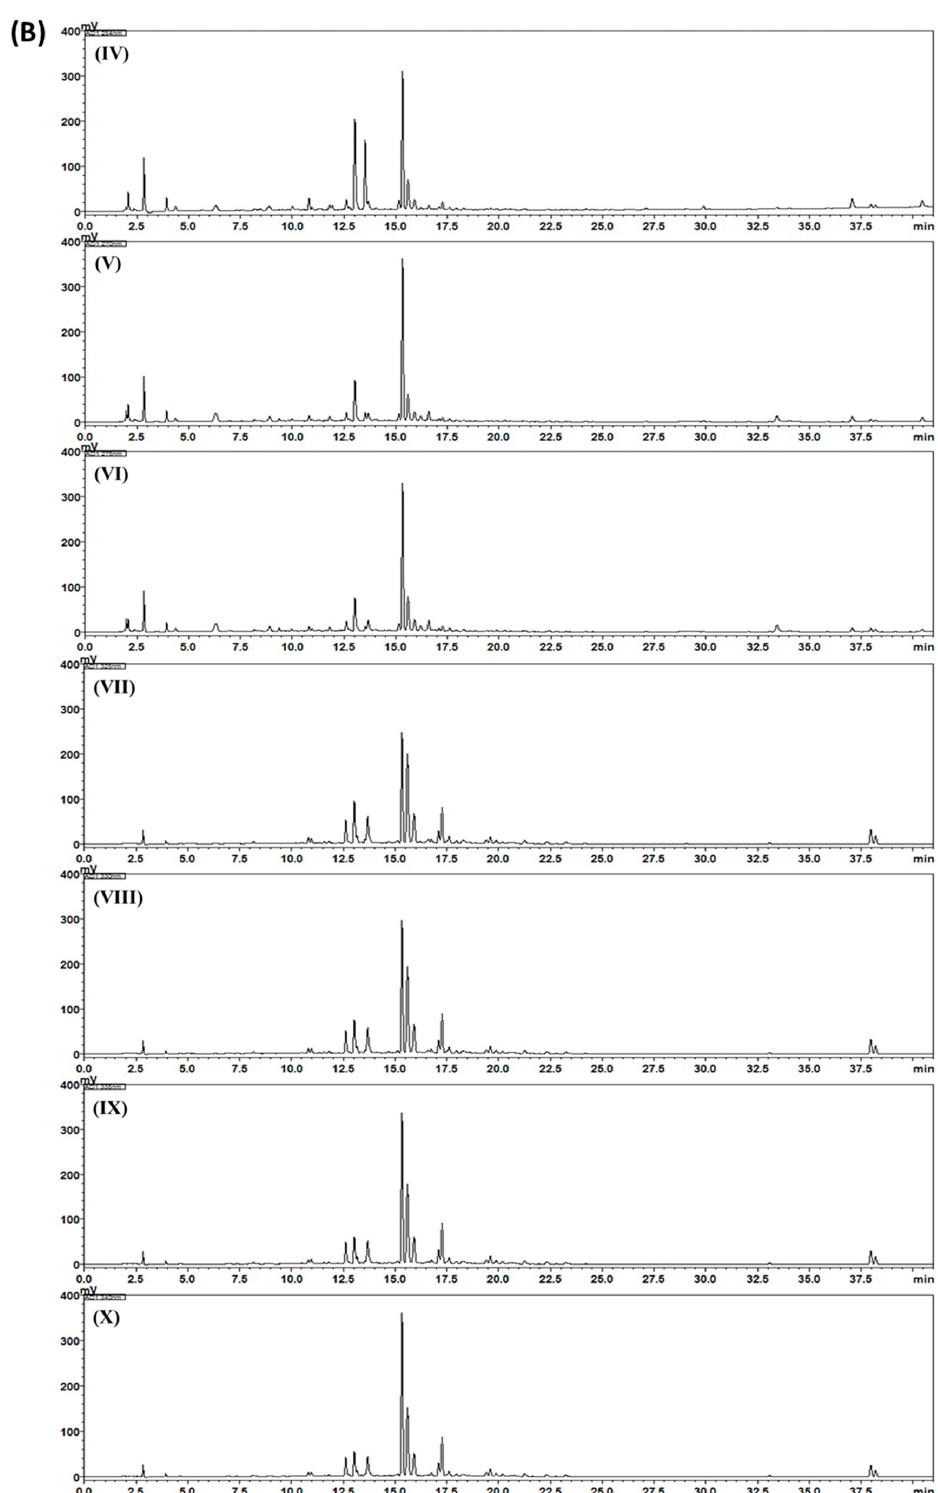
Figure 2. Representative high-performance liquid chromatography (HPLC) chromatograms of the standard solution ( A ) and Gami-soyosan sample ( B ) at a 220 (I), 230 (II), 240 (III), 254 (IV), 270 (V), 275 (VI), 325 (VII), 330 (VIII), 335 (IX), and 340 (X) nm. Gallic acid ( 1 ), neomangiferin ( 2 ), chlorogenic acid ( 3 ), mangiferin ( 4 ), geniposide ( 5 ), albiflorin ( 6 ), paeoniflorin ( 7 ), berberine chloride ( 8 ), liquiritin apioside ( 9 ), liquiritin ( 10 ), nodakenin ( 11 ), benzoic acid ( 12 ), liquiritigenin ( 13 ), benzoylpaeoniflorin ( 14 ), glycyrrhizin ( 15 ), atractylenolide III ( 16 ), decursin ( 17 ), and decursinol angelate ( 18